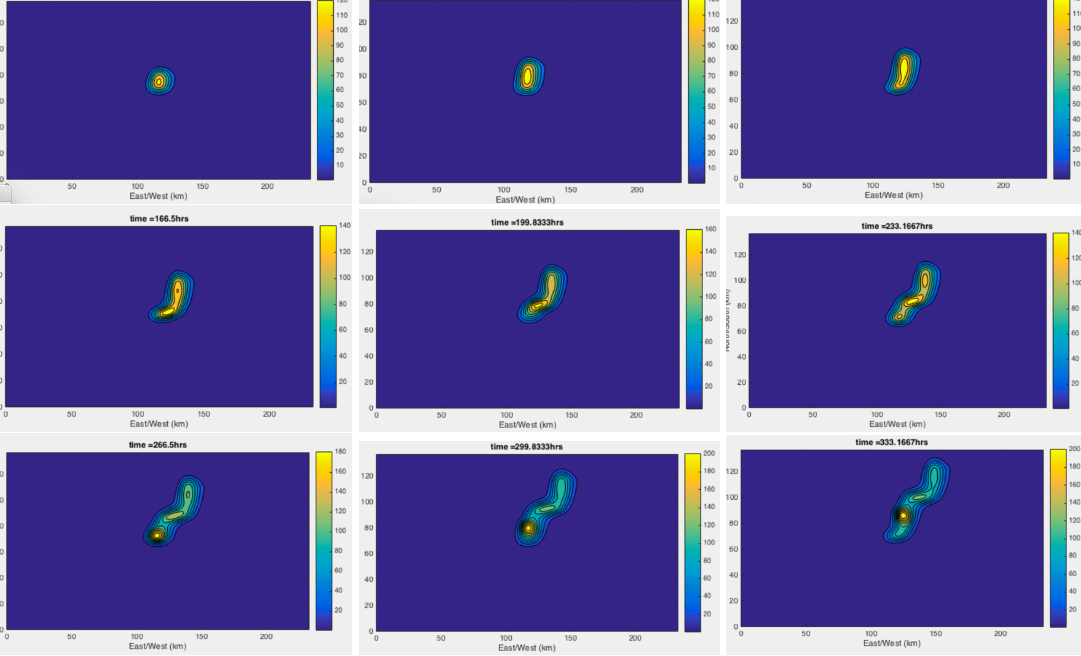
Figure 18. Summer conditions, currents and waves. Evolution of tracer leading to Figure 17b. The current is steady at 0.18 m/s, directed in the North East direction. The wave-induced Stokes drift and the currents are comparable in